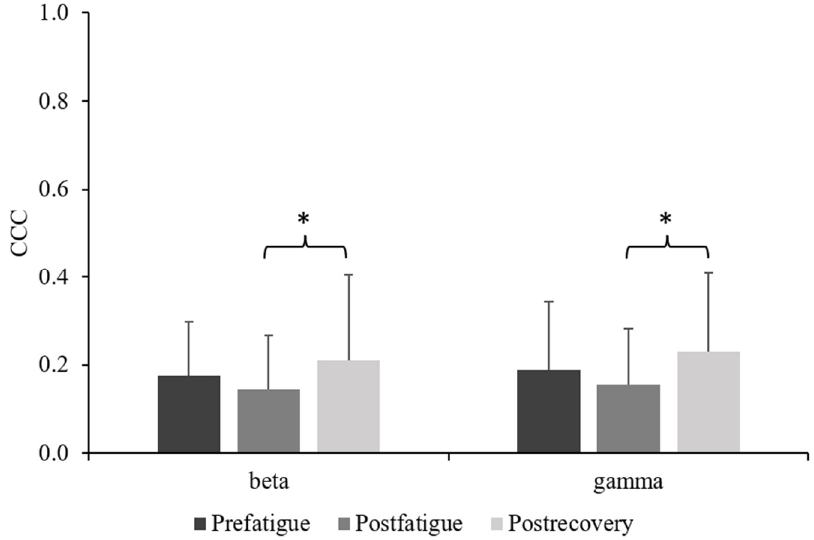
Figure 6. Comparison of C3–C4 corticocortical coherence among the prefatigue, postfatigue, and postrecovery states. (* p < 0.05)